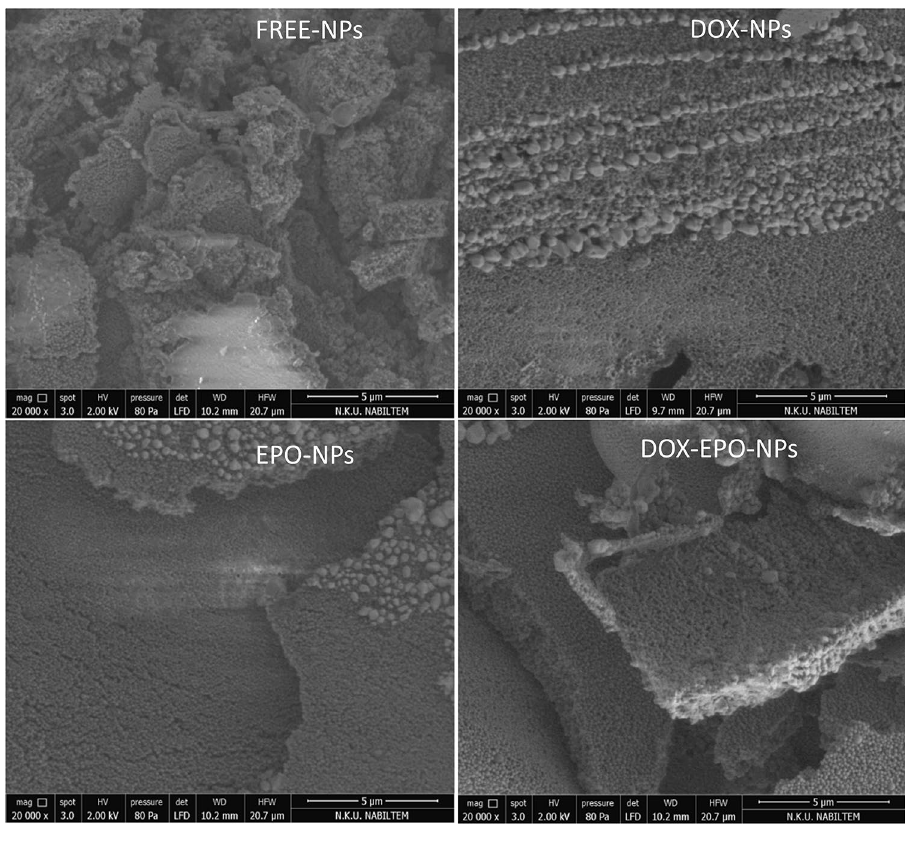
Figure 1. SEM images of free, Dox loaded NPs, Epo loaded NPs, and Dox-Epo loaded NPs.